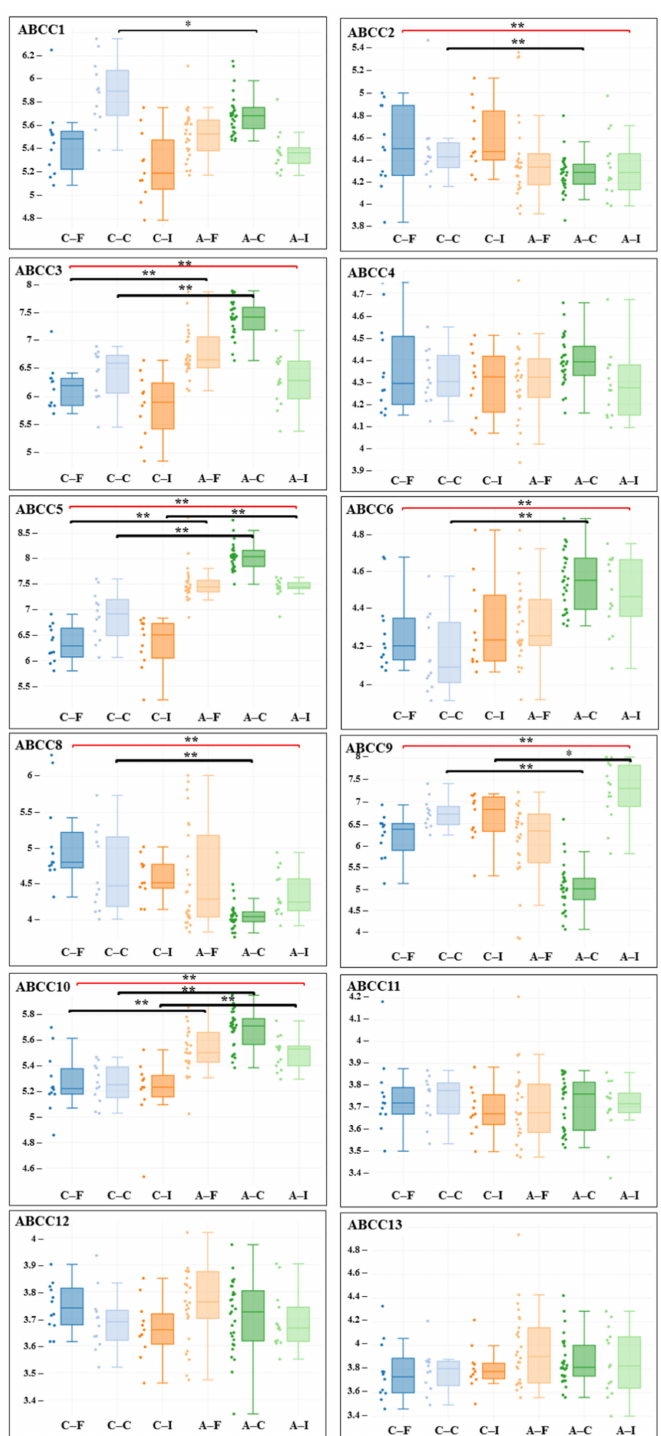
Figure 3. Gene expression patterns of the ABCC subfamily in the comparison groups: atherosclerotic— femoral artery (A–F); atherosclerotic—carotid artery (A–C); atherosclerotic—infra-popliteal artery (A–I); control—femoral artery (C–F); control—carotid artery (C–C); control—infra-popliteal artery (C–I). The red line shows the differences in gene expression in the group between all sets with atherosclerosis and all control sets. The data distribution is visualized in the form of box diagrams. Statistically significant differences ( p values adjusted using the algorithm of Benjamini– Hochberg (adj. P. Val)) shown with asterisks: * p < 0.05, ** p <